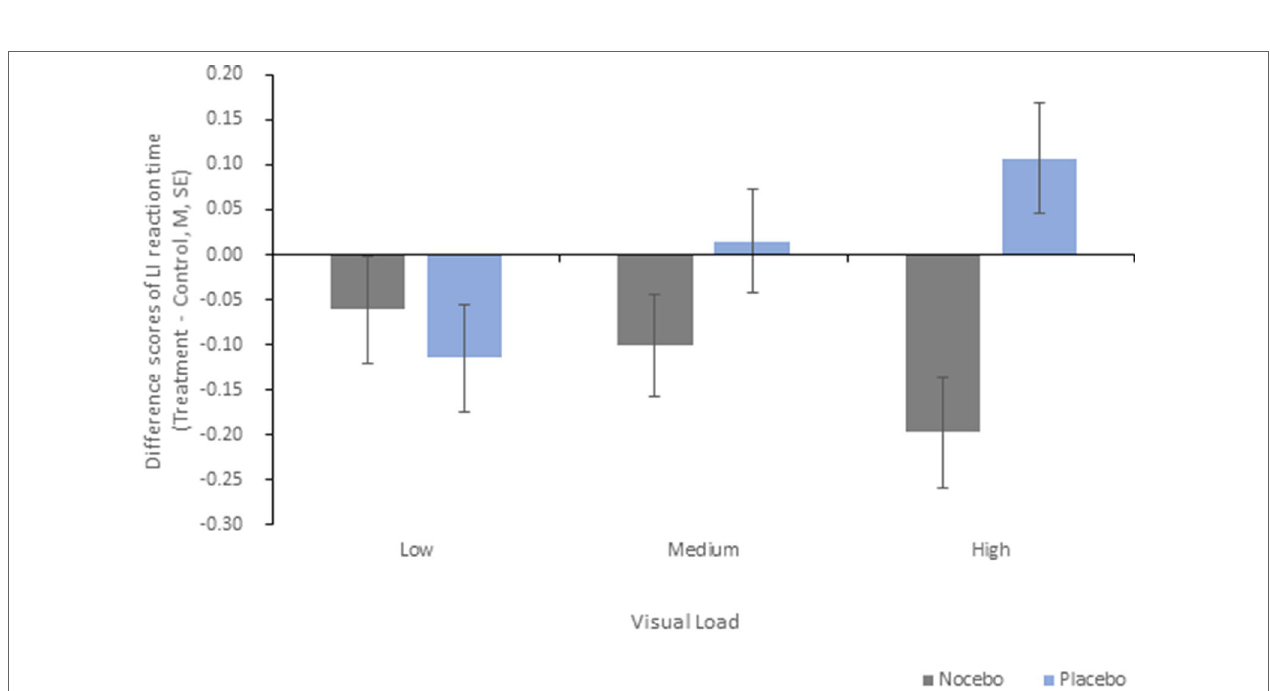
FIGURE 3 | Mean difference scores and standard errors for percentages of left-sided fixations for the main effect group. Positive values indicate a higher percentage of left-sided fixations in the treatment condition (placebo or nocebo) compared with the control